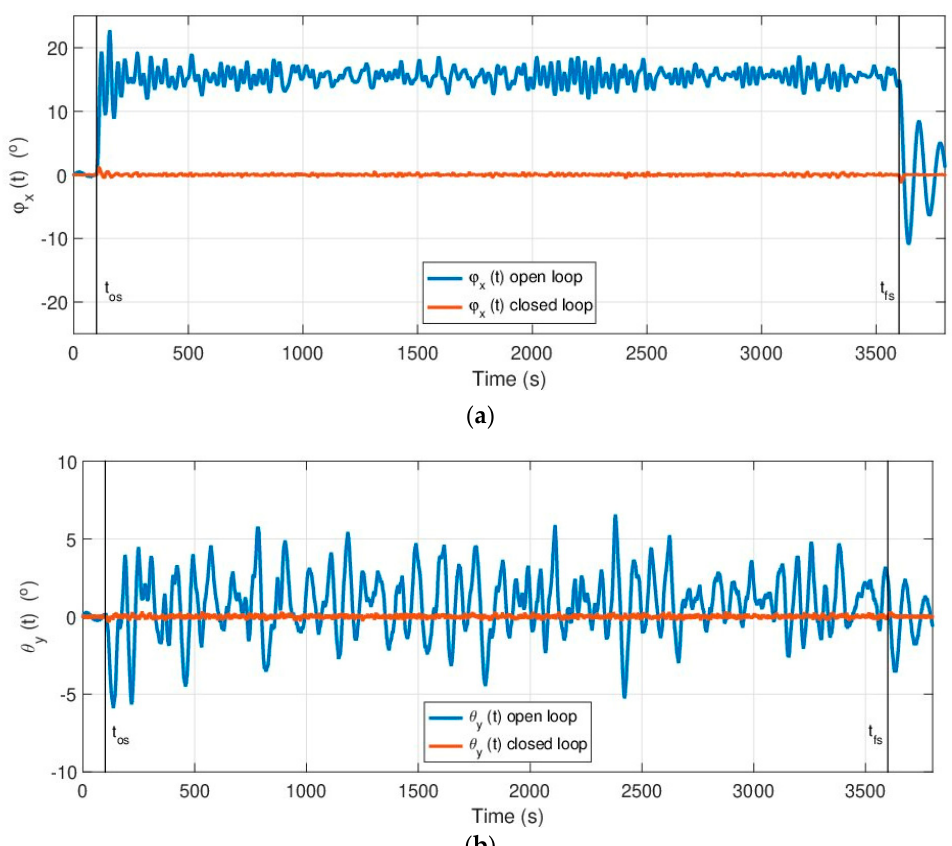
Figure 16. Full simulation of the open loop and closed loop response of the device with real wind and waves data taken from [29]. ( a ) Open loop and closed loop responses for the 𝑥 -axis rotation. ( b ) Open loop and closed loop responses for the 𝑦 -axis rotation